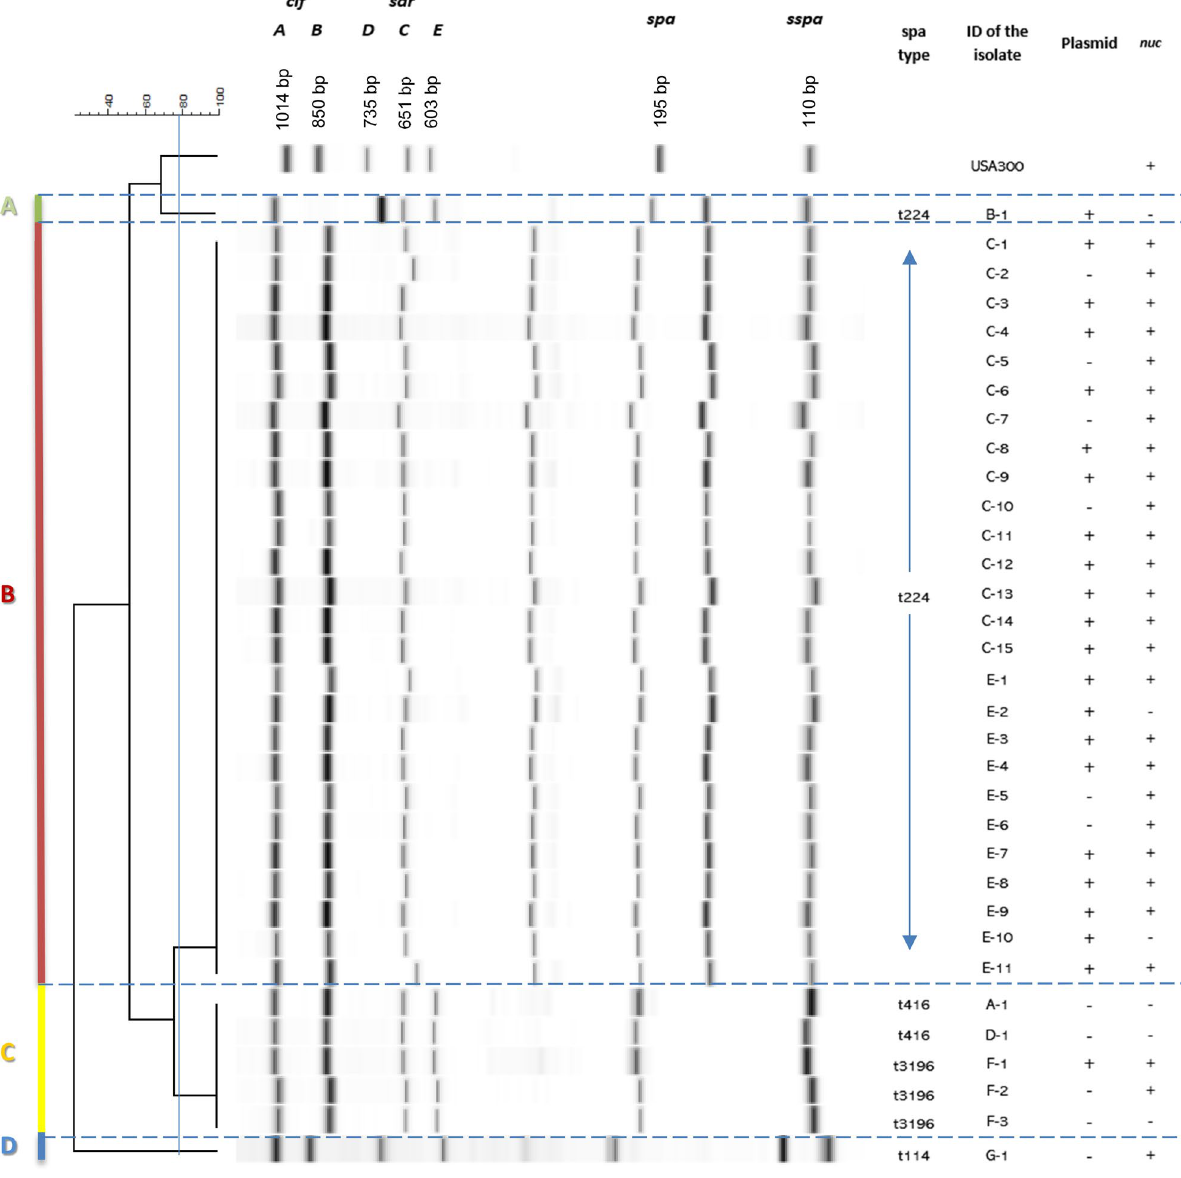
determined for S. aureus (33 mol%) 23 . Based on DNA sequence similarity, plasmid pSAM1 can be classified as a rolling circle replicating (RCR) plasmid that belongs to the pSN2 Family 21 . In total, six ORFs were identified on pSAM1 (Fig. 5). The largest identified orf of pSAM1 encodes a protein of 154 amino acid (AA) residues which, on the basis of sequence similarity, corresponds with the replication protein RepL. Downstream of the repL gene, the orf2 gene is located, which encodes a protein of 62 residues with unknown function. An inverted repeat with a ∆G° of − 12.6 kcal/mol that may function as a rho-independent terminator is located downstream of orf2 . 136-bp